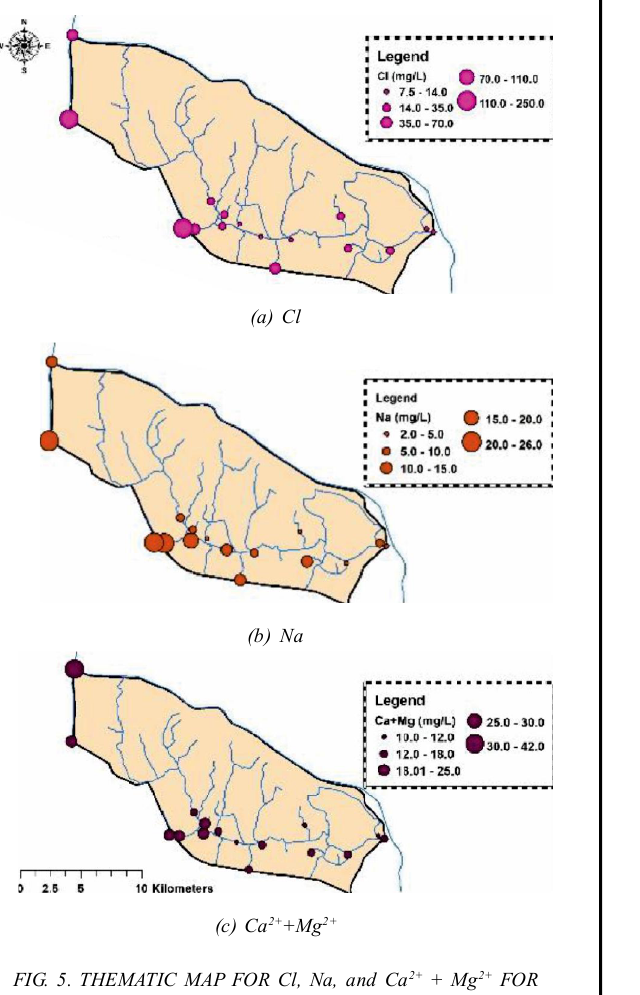
FIG. 5. THEMATIC MAP FOR Cl, Na, and Ca 2+ + Mg 2+ FOR WATER SAMPLES COLLECTED FROM THE STUDY